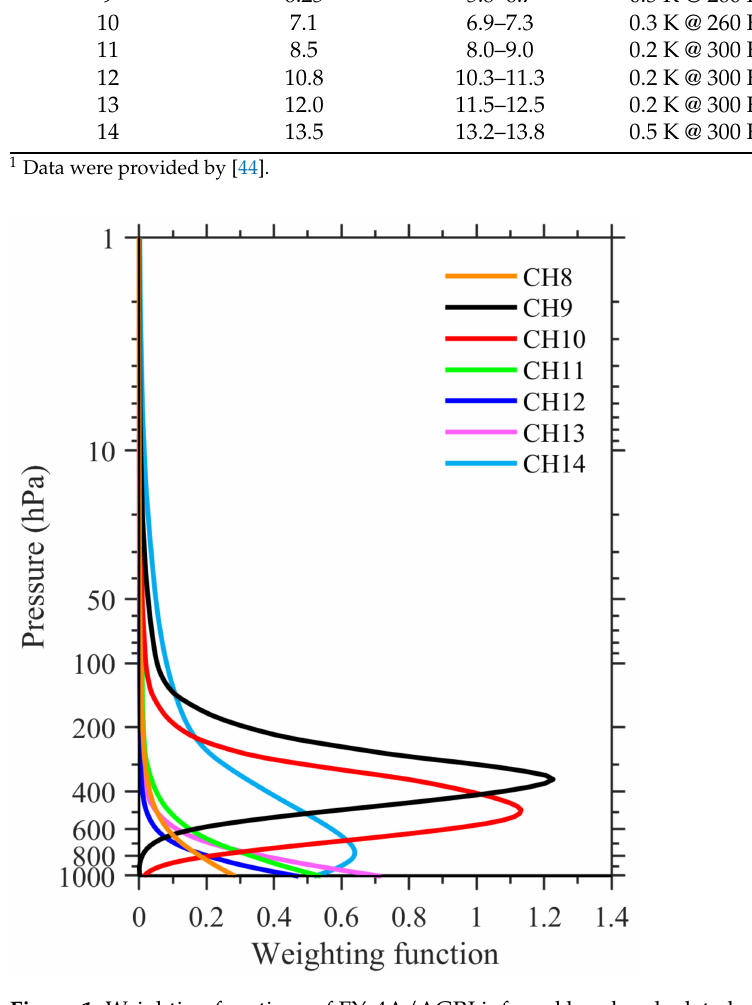
Figure 1. Weighting functions of FY–4A/AGRI infrared bands calculated using ARMS with the US 1976 standard atmosphere as the